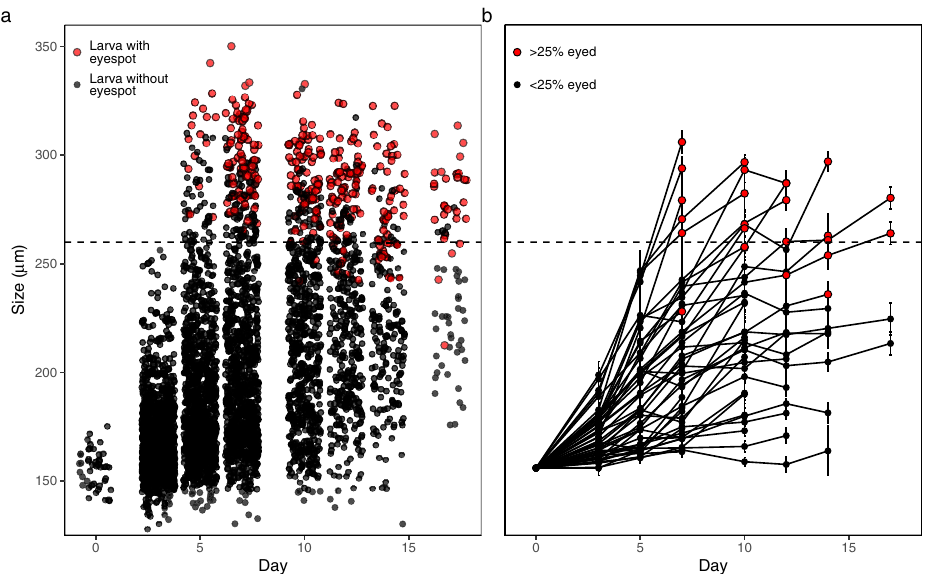
Figure 3. Size values through time of all larvae across experimental treatments. ( a ) Larval sizes in all treatment cups where black dots represent non-competent larvae (lacking a visible eyespot) and red dots represent competent larvae. ( b ) Average sizes with error bars ± SE for larval treatment cups. Red dots represent samples where over 25% or larvae sampled were visibly competent. In both plots, the horizontal line at 260 µm represents the size at which we considered larvae late-stage